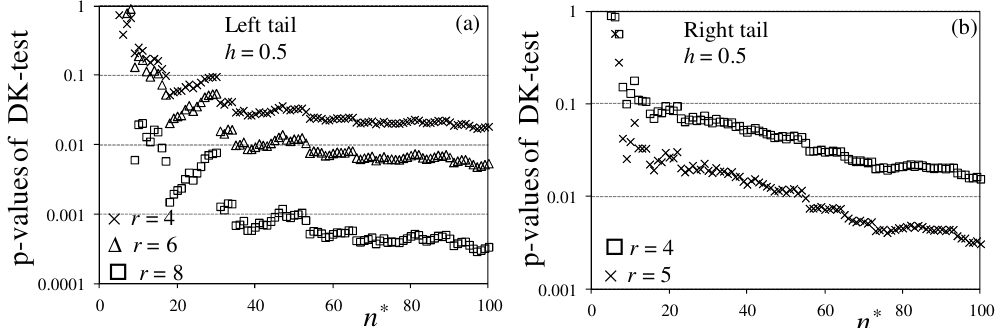
Fig. 16. DK test p values of increments along x direction on Berea sandstone block at s = 10 1 : (a) left tail and r = 4 , 6 , 8, (b) right tail and r = 4 ,